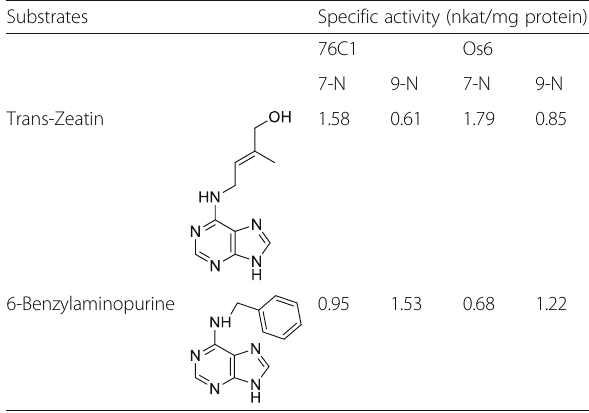
Table 1 The Km values of OS6, which glycosylate trans-zeatin and 6-Benzylaminopurine